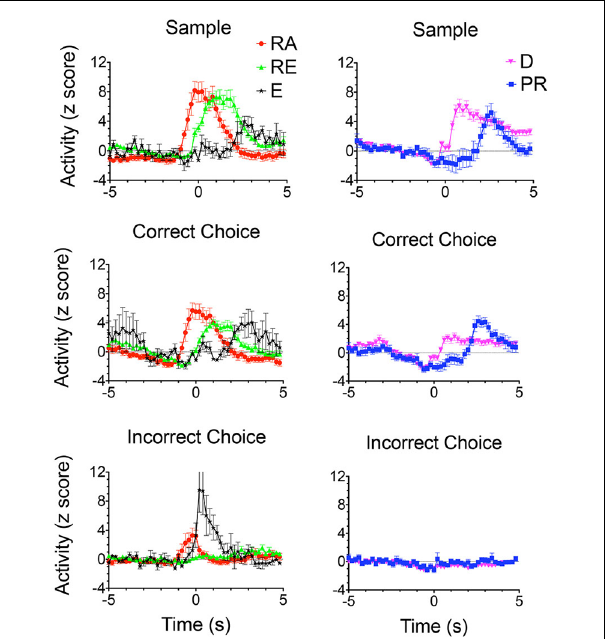
FIGURE 8 | Normalized population PETHs based on all examples observed of outcome-related responses. Each of these responses differentiated reinforced sample and correct choice responses from unreinforced incorrect choices. Reinforcement anticipation (RA) responses began 0.6–0.8 s before sample and choice responses and lasted until 1.6 s after reinforcement began or 0.2 s after errors when reinforcement was not delivered ( N = 50). Reinforcement excitation (RE) began when reinforcement was delivered and lasted an average of 2.7 s ( N = 63). Error (E) responses lasted for an average of 1.6 s after incorrect responses when expected reinforcement was not delivered ( N = 4). Delay-related responses exhibited increased activity lasting across the memory delay, on average from 0.4 to 5.0 s after sample reinforcement and 0.2–1.6 s following correct choice reinforcement ( N = 58). Some delay-related had spatially-restricted firing patterns ( Figures 9A,B,F ) and thus potentially carried information about the location of sample reinforcement across the delay interval sufficient to support a correct DNMTP choice. Post-reinforcement responses lasted on average from 2.3 to 3.6 s after reinforcement began, a time when rats tended to disengage after consuming reinforcement from the drinking spout ( N = 16). Activity is aligned with each of the lever presses and plotted for 5 s before and after the aligned event. Error bars represent the standard error of the mean. Data are replotted from Francoeur and Mair